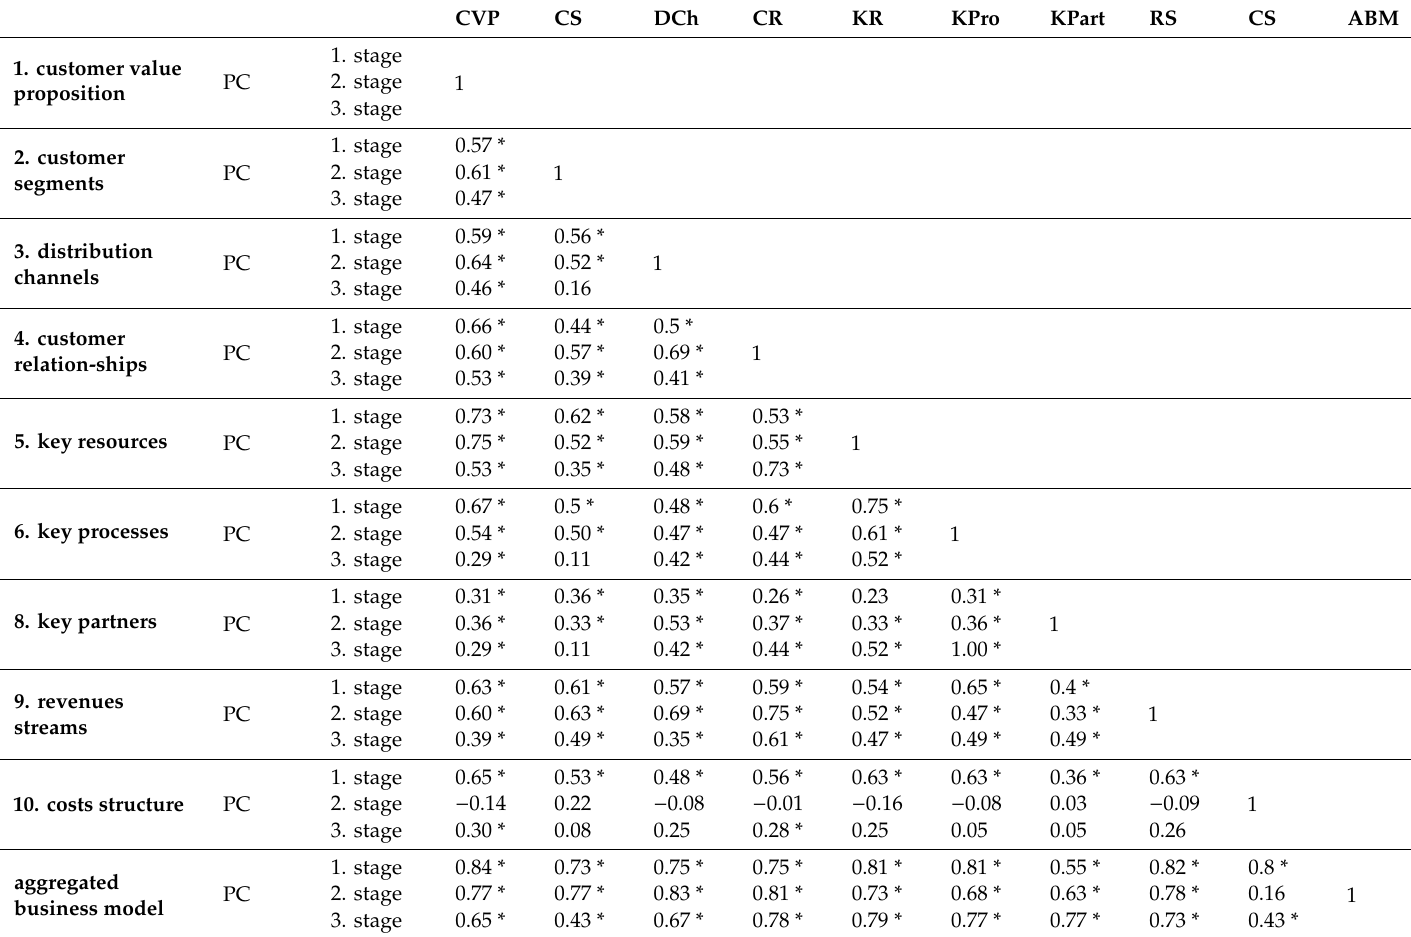
Table A1. Correlation of blocks of business model / correlation matrix in three stages of